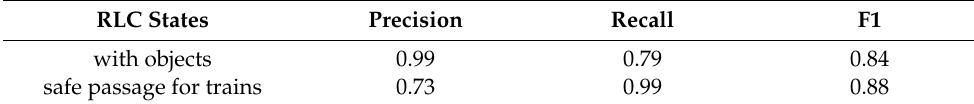
Table 2. Determination of the RLC states using